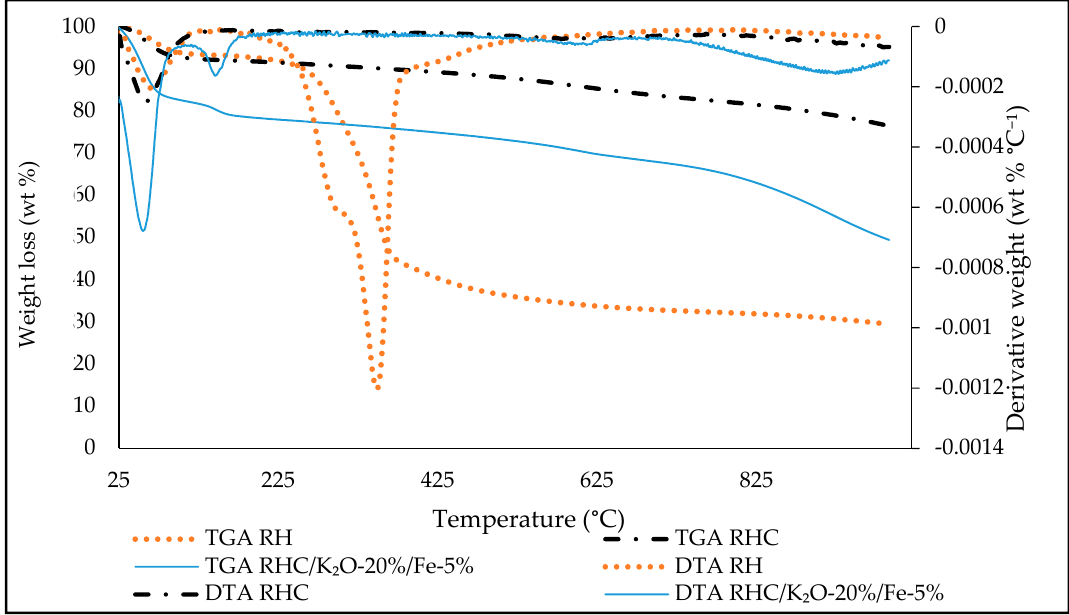
Figure 2. Thermogravimetric analysis- Differential thermal analysis ( TGA-DTA) curves of the rice husk (RH), rice husk char (RHC) and nano-magnetic RHC/K 2 O-20%/Fe-5% catalysts.